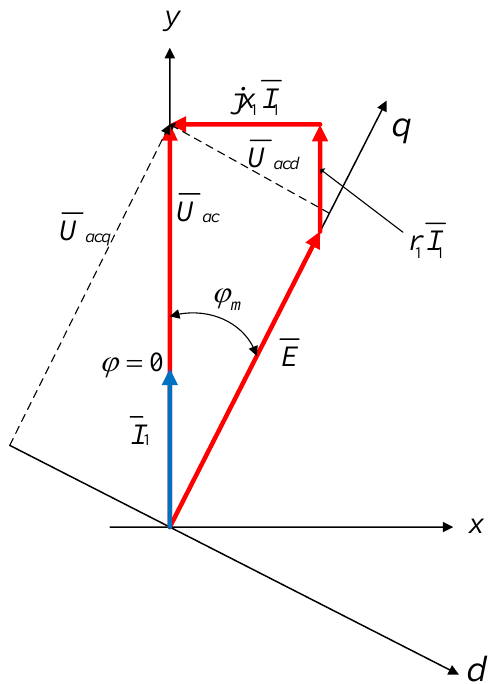
Figure 4. Vector diagram of inverter–PMSM system during energy optimization. By performing the energy optimization (Figure 4), U acd , U acq control signals in d , q coordinates are set in such a way that the phase shift between the voltage vector I at the inverter output is equal to zero ( φ = 0) (Figure 4). This is the current vector 1